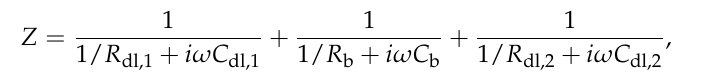
Table 2. Crystal and hydrated radii of Na + , K + , Cl − and NO −